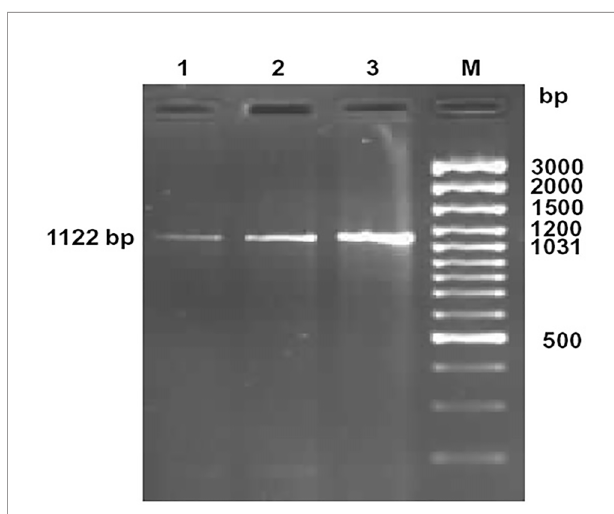
FIGURE 1 | Ampli fi cation of 1122bp fragment of CD14 gene of sheep and goat. Lane 1-2: Ampli fi ed product from cDNA of CD14 gene of sheep Lane M: 100bp DNA ladder